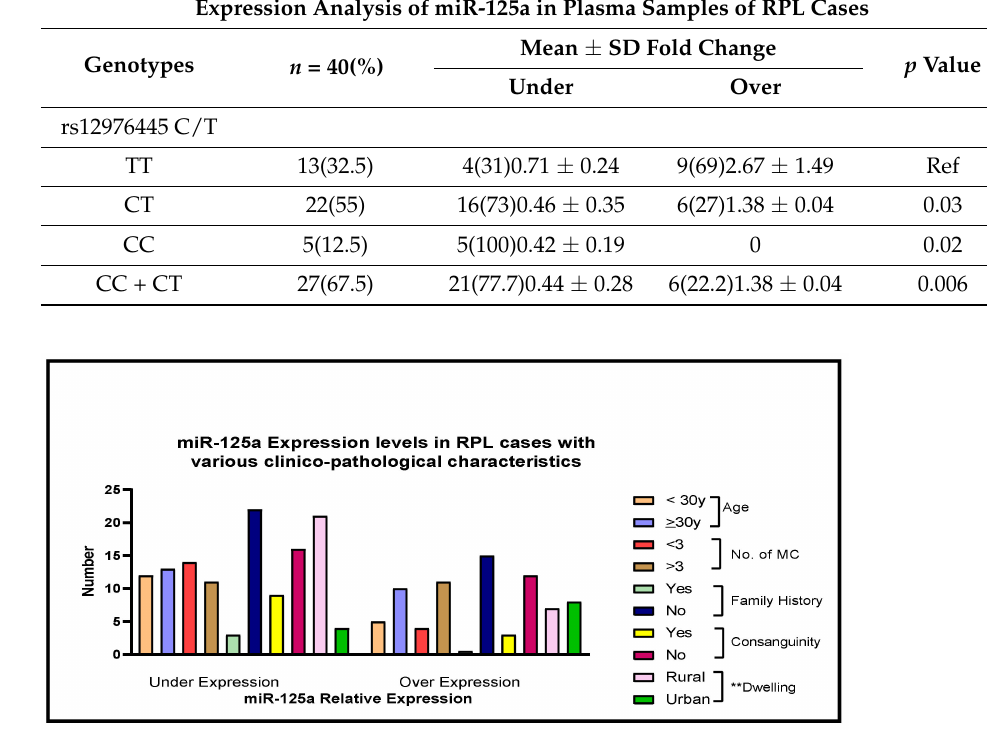
Figure 6. The association between different clinico-pathological variables and miR-125a expression levels in Recurrent Pregnancy Loss (RPL) cases (** represents significant, MC;